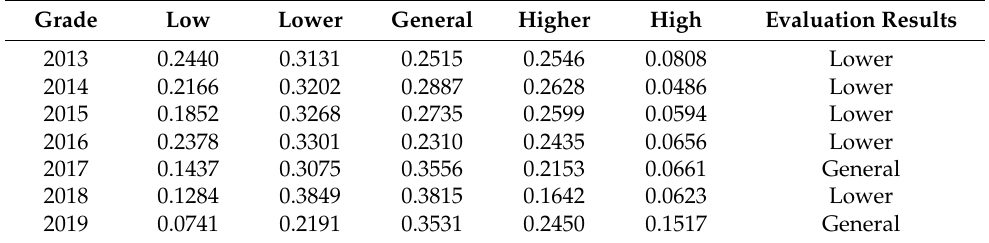
Table 11. Evaluation Results of Logistics Decarbonization Development in Tianjin